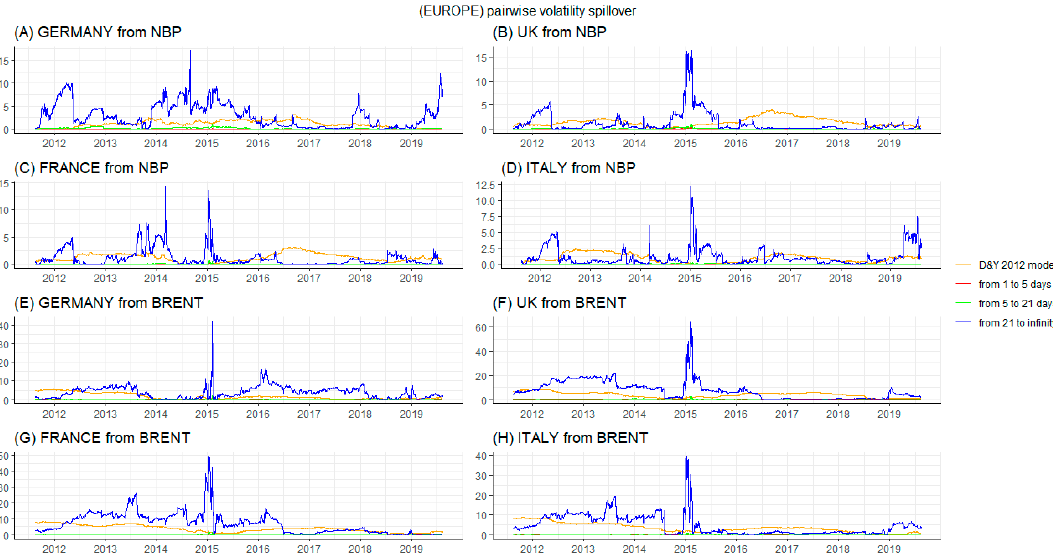
Figure A4. Pairwise directional volatility spillover of DY12 and BK18 in Europe. Notes: GERMANY from NBP indicates the volatility spillover from natural gas to Germany; UK from NBP indicates the volatility spillover from natural gas to the UK; FRANCE from NBP indicates the volatility spillover from natural gas to France; ITALY from NBP indicates the volatility spillover from natural gas to Italy; GERMANY from BRENT indicates the volatility spillover from crude oil to Germany; UK from BRENT indicates the volatility spillover from crude oil to the UK; FRANCE from BRENT indicates the volatility spillover from crude oil to France; ITALY from BRENT indicates the volatility spillover from crude oil to Italy.